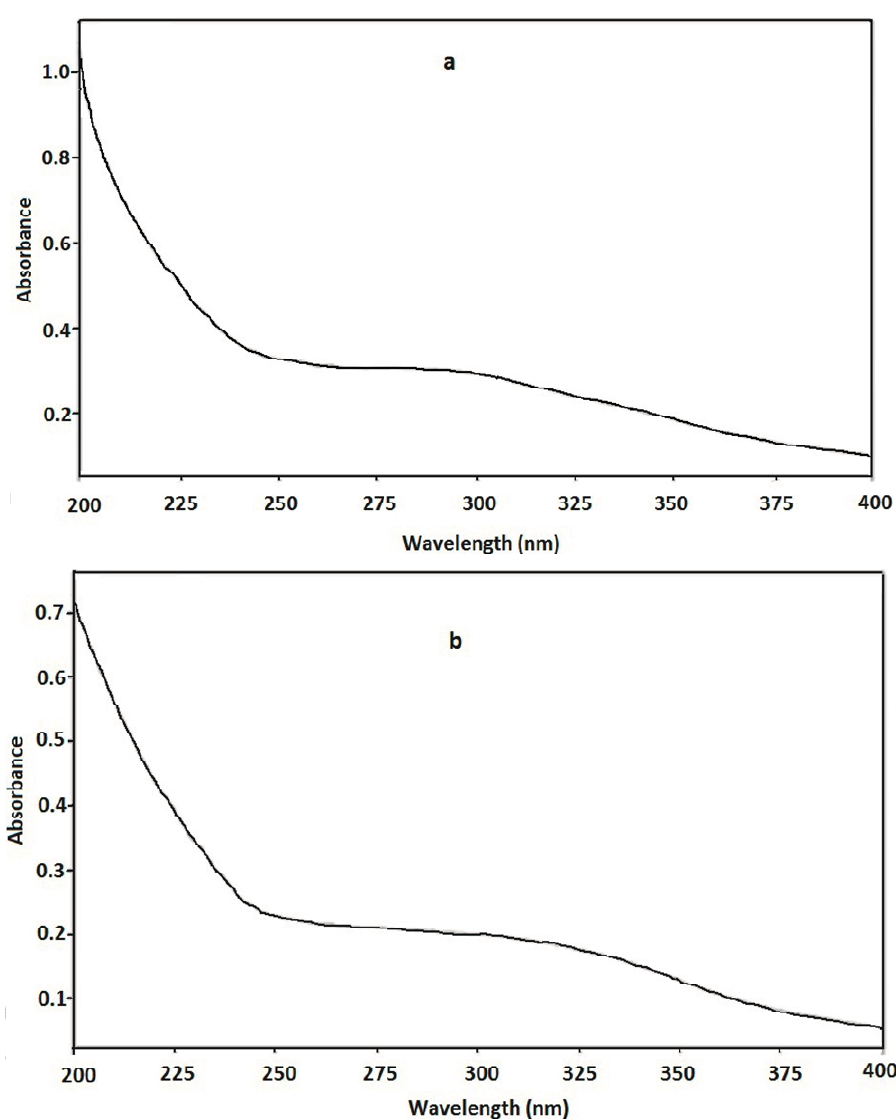
Figure 3. The UV spectra of ( a ) PEA-1 and ( b )